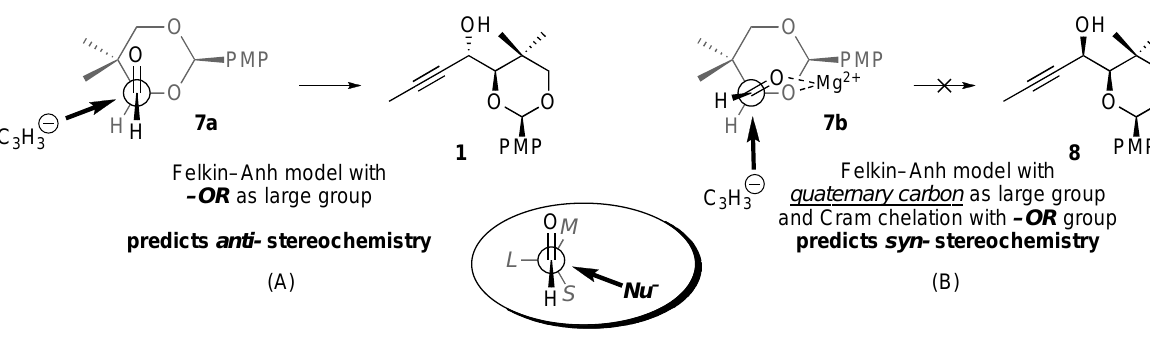
Figure 2. Alternative Felkin–Anh models for predicting/assigning